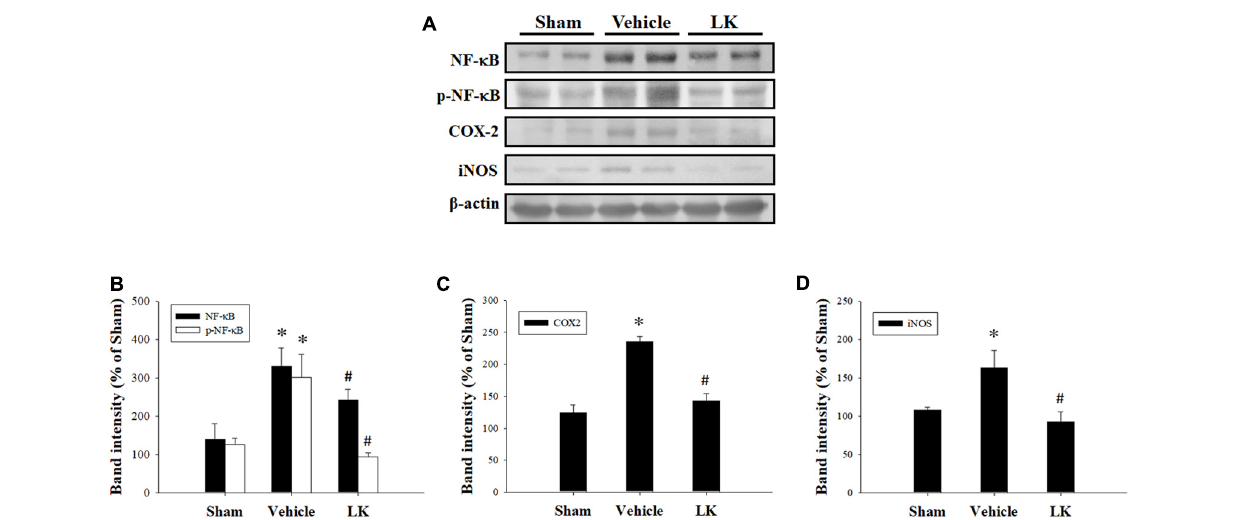
FIGURE 5 | Post-ischemic lumbrokinase treatment reduced levels of inflammation induced by myocardial I-R injury. (A) Representative images of the Western blot results. Quantitative densitometric analysis of (B) NF- κ B and p-NF- κ B, (C) COX-2, and (D) iNOS protein expression in rat myocardium after myocardial I-R injury. Data are normalized with values from the sham group and presented as percentage rates. Each value is represented as the mean ± SEM ( n = 3). ∗ p < 0.05 compared with the sham group; # p < 0.05 compared with the vehicle group.